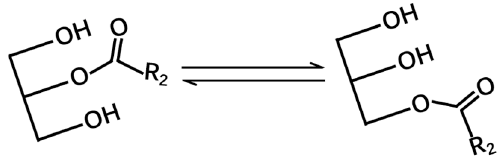
Figure 3. The migration of 2-MAG to